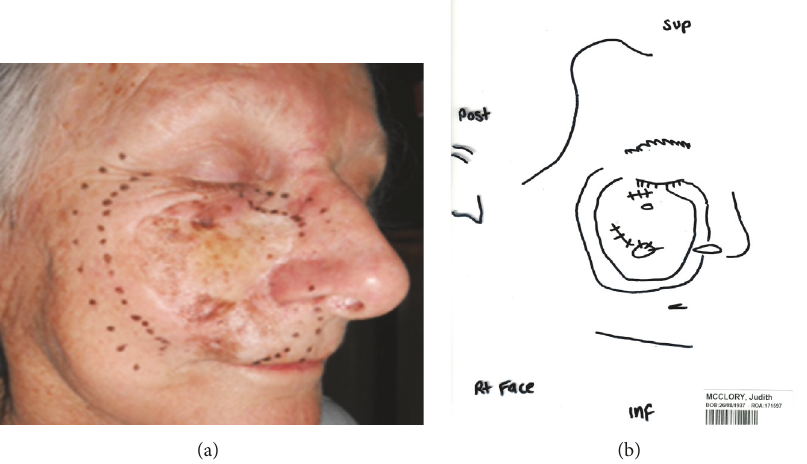
Figure 3: (a) This lady had a large area of lentigo maligna that has failed a surgical graft mapped out on her right medial cheek. The radiation oncologist has duplicated the RCM area onto that face. At least a 1 cm margin is then put around that area to act as field edge. (b) The radiation therapists have then produced a template on a piece of plastic which will be used to transfer marks onto the mask and will be used every day for treatment verification on the machine. This piece of plastic can be stored in an electronic medical records system and be emailed to a dermatologist or any other caring doctor in the future if the radiotherapy area is ever needed to be delineated or known, for example, if there is recurrence of lentigo maligna and the team wants to know whether the lentigo maligna recurrence is in-field or not or a field edge recurrence.